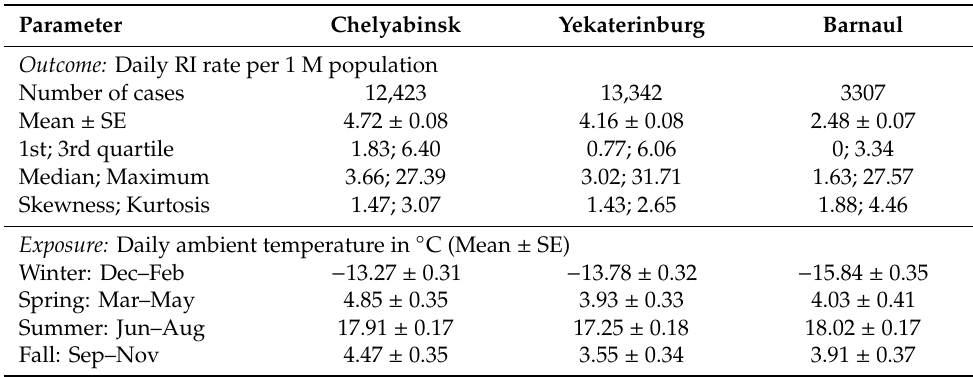
Table 2. Statistical characteristics of daily rates of rotaviral infection (RI) (outcome) and daily average temperature (exposure) for three Russian cities: Chelyabinsk, Yekaterinburg, and Barnaul,